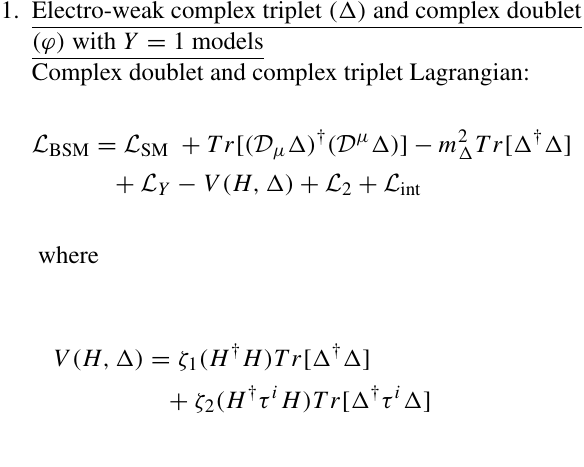
and Wilson coefficients for complex doublet and complex triplet models. These two fields are degenerate in mass, i.e., m (cid:17) = m ϕ . As the light–heavy mixing (which can be ignored safely for phenomenological analyses) is not included, this result is